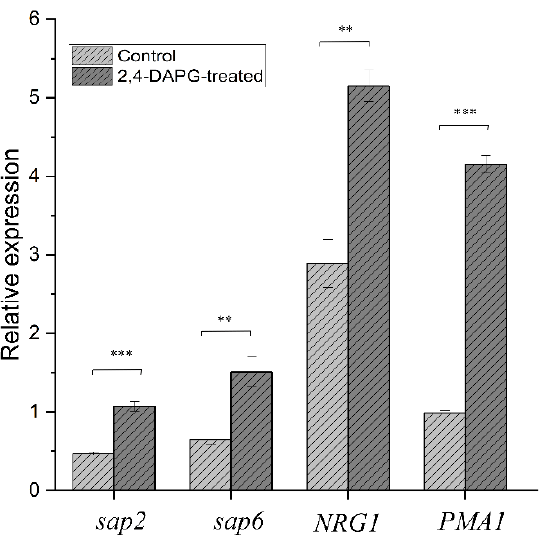
Figure 7. The analysis of the expression level of genes responsible for protease production and hyphae filamentation. Transcript levels of the analyzed genes were determined by RT-qPCR in relation to the ACT1 expression. Sap2 —the gene responsible for the synthesis of Sap 1–3 proteases; Sap6 —the gene responsible for the synthesis of Sap4–6 proteases; NRG1 —the negative regulator of filamentous growth; PMA1 —the gene of H + ATPase. The means plus standard deviations of results from three technical replicates are shown. Values that are significantly different from the values for “control” are indicated **— p < 0.01; ***— p < 0.001 (pair-sample Student’s t -test).